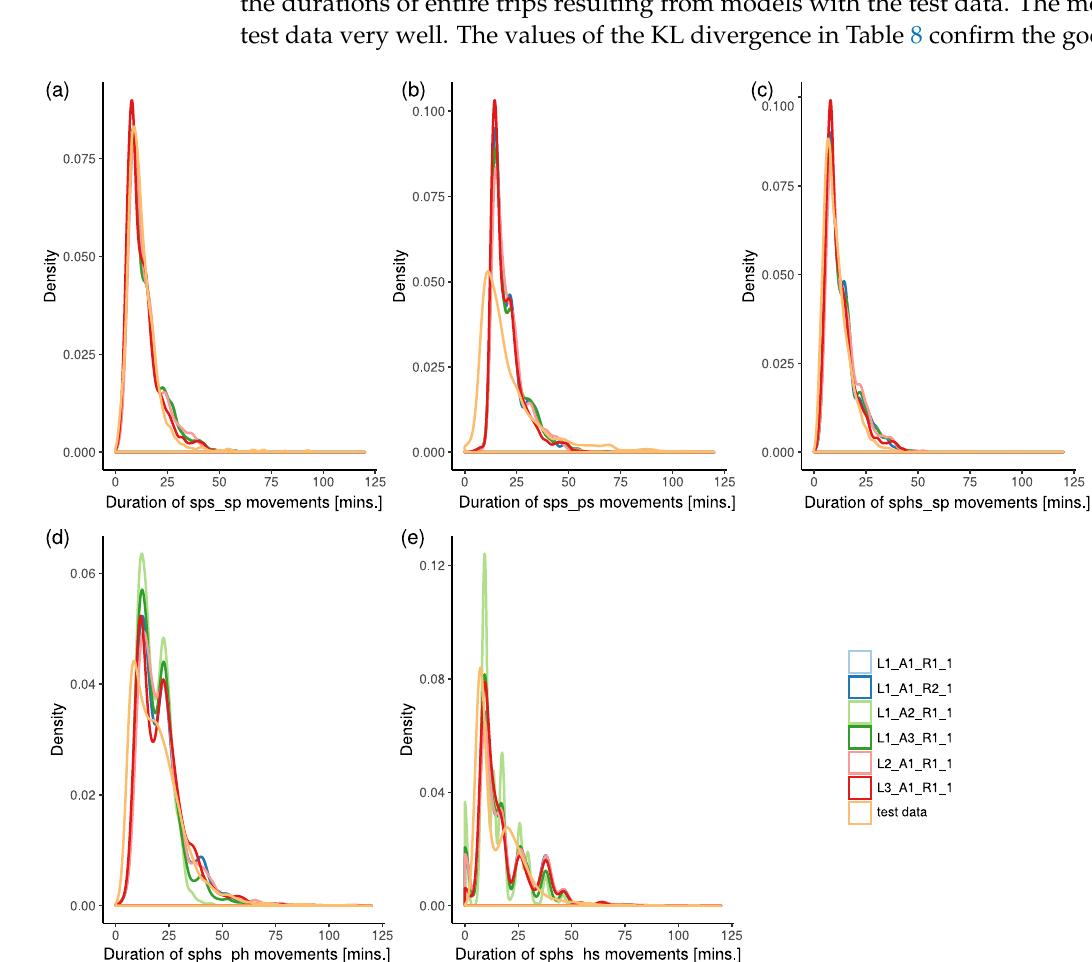
Figure 15. The probability density functions of movement duration. Each panel ( a – e ) corresponds to a different movement type of “sps” and “sphs” trips (indicated by the x-axis label). The default settings, i.e., L 1_ A 1_ R 1, are compared with test data, a linear model ( L 2), empirical probabilities ( L 3), the allocation of emergency cases to the closest hospital ( A 2), closest hospital-specific empirical probability distributions ( A 3), and shortest path routing ( R